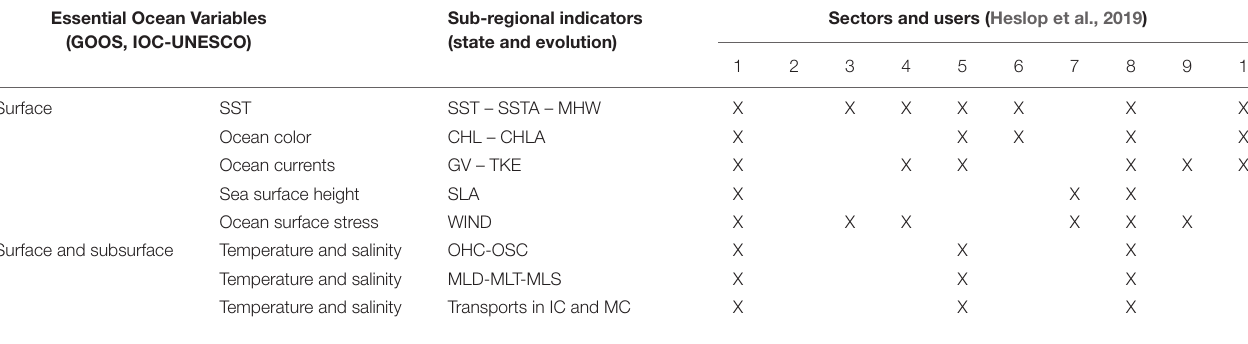
TABLE 1 | Essential ocean variables, sub-regionally integrated ocean indicators, associated sectors and users as listed in Table 2 . Essential Ocean Variables (GOOS,